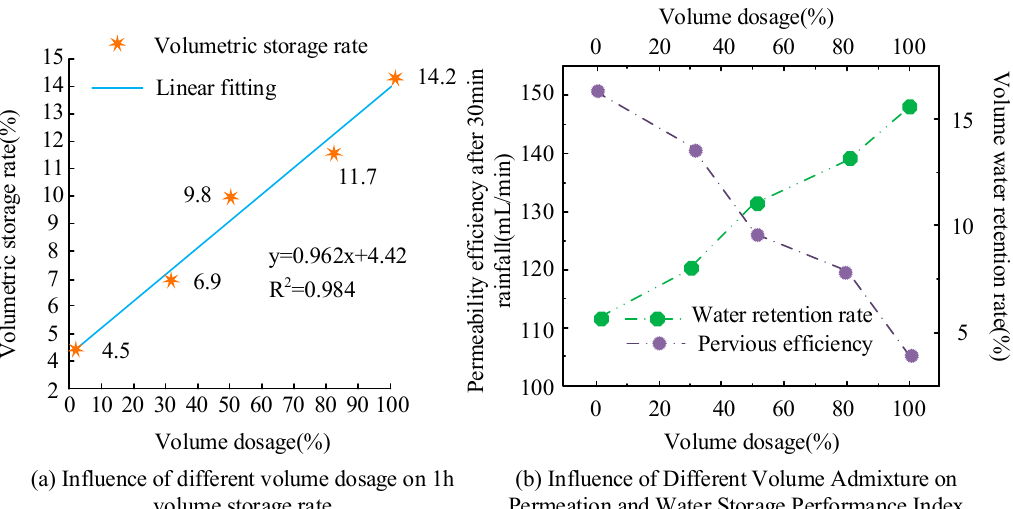
Figure 8. Outcomes of influence of different volume dosage on 1 h volume storage rate and infiltration storage performance